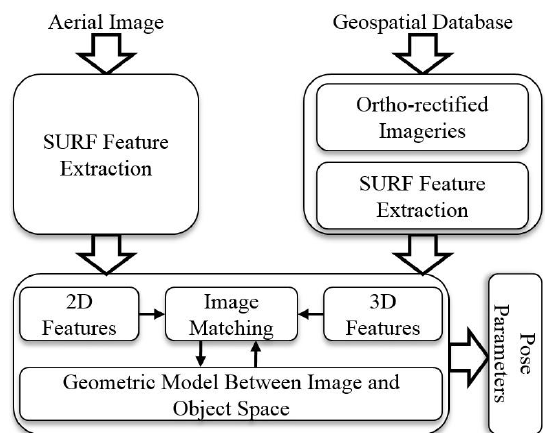
Figure 2. The proposed vision-aided navigation